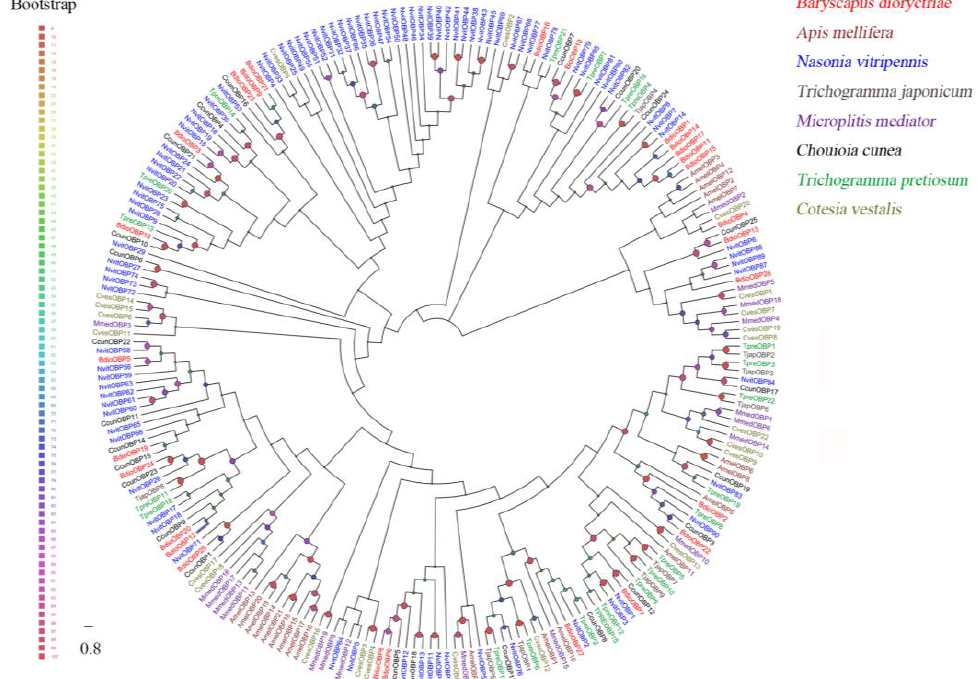
Figure 1. Phylogenetic tree of 233 odorant-binding proteins (OBPs) from B. dioryctriae and seven other Hymenoptera species. The protein sequences used in this phylogenetic analysis are listed in File S1. The size and color of the dots reflect their bootstrap values. The color scale is shown on the left, with larger dots indicating larger bootstrap values.